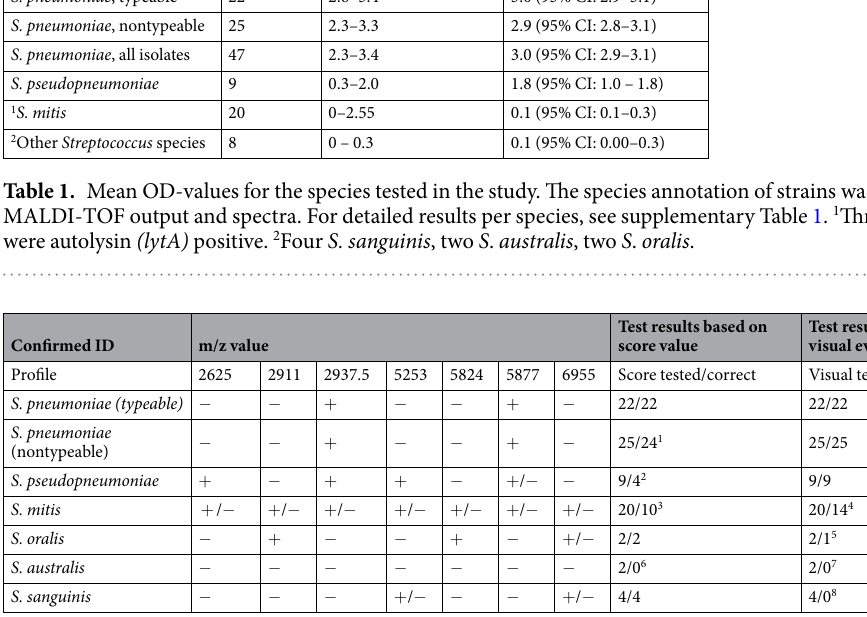
Table 2. Comparison of species identification by official (Score value) and visual interpretations of MALDI- TOF seven profile peaks, with species annotation based on the m/z values described by Werno et al . 7 . + : only strains with peaks were found. + / − : strains both with and without peaks were detected. − : no strains with peaks were detected. 1 One specimen identified as S. pseudopneumoniae . 2 Four isolates identified as S. pneumoniae , one ID as S. oralis . 3 Six isolates identified as S. oralis , three isolate ID as S. pneumoniae , one isolate ID as S. pseudopneumoniae . 4 Three isolates identified as S. pneumoniae , three S. mitis / S. oralis . 5 One isolate identified as S. mitis / S. oralis . 6 Both isolates identified as S. parasanguinis . 7 Both isolates could not be identified. 8 All